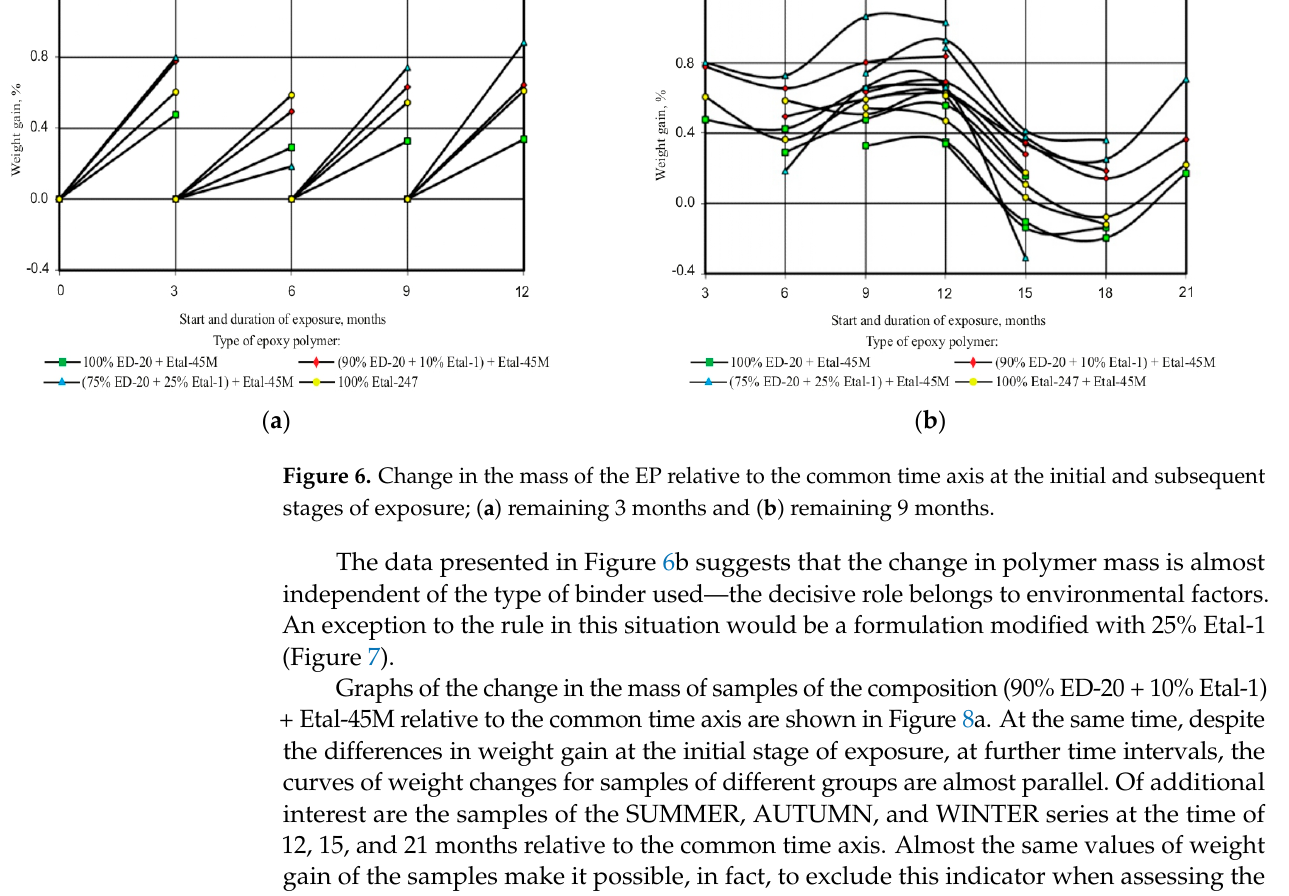
Figure 7. Change in the mass of epoxy polymer samples (75% ED ‐ 20 + 25% Etal ‐ 1) + Etal ‐ 45M rela ‐ tive to the common time axis for water absorption. It has been established that for all types of aggressive media, a linear increase in the limiting moisture absorption is observed with an increase in the content of the diluents Etal ‐ 1 (Figures 7 and 8).